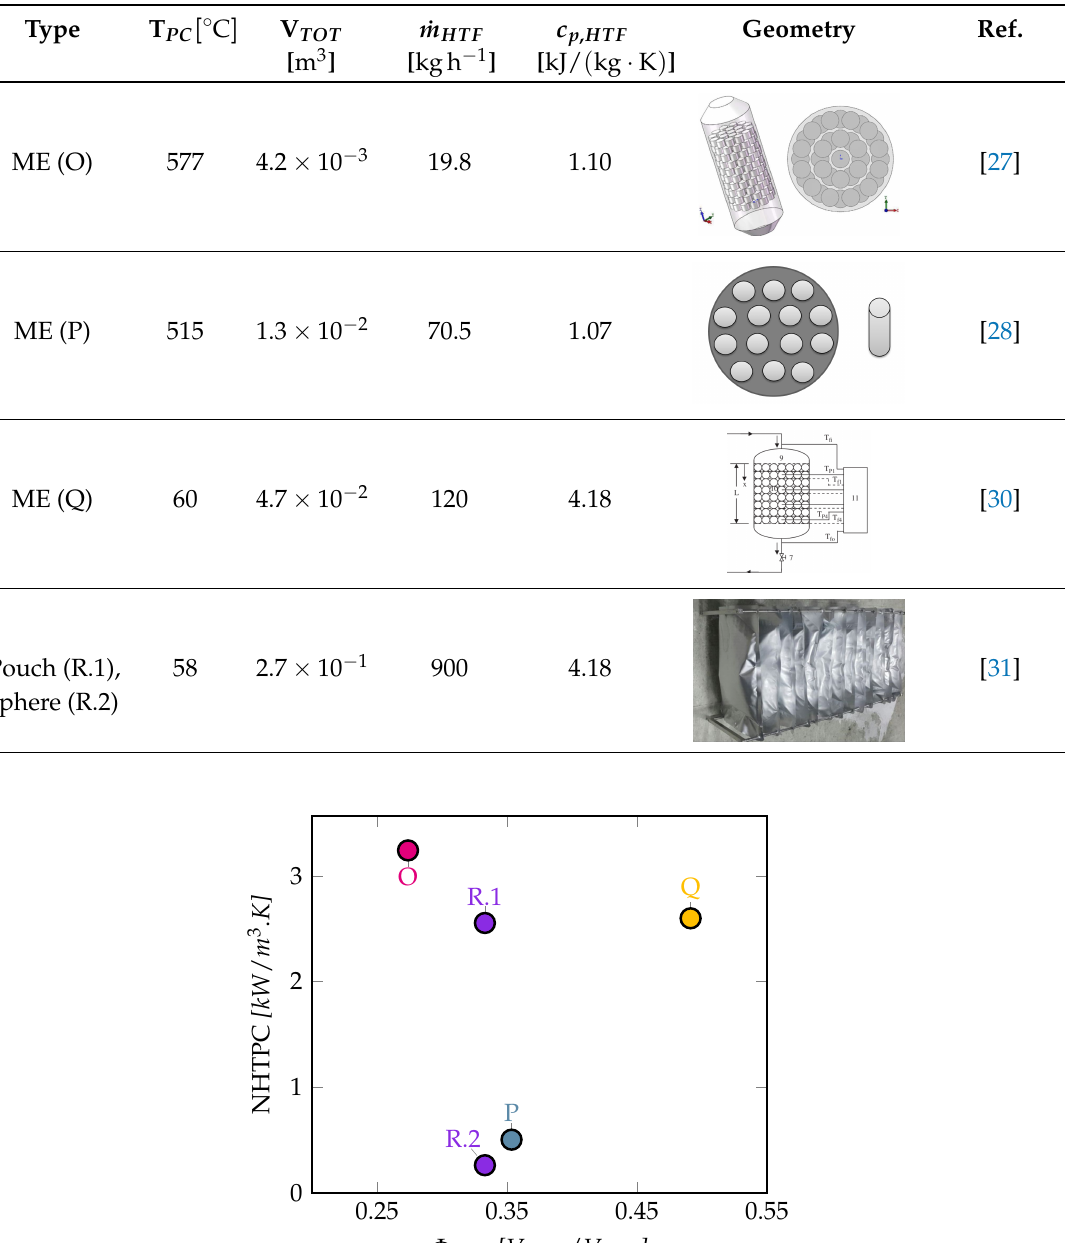
Figure 5. Calculated NHTPC vs. Φ PCM for the references concerning macro encapsulation techniques in LHES unit